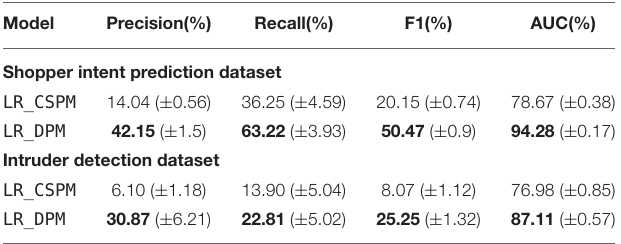
TABLE 3 | Comparison of averaged intent classification performance by using Logistic Regression model on CSPM and DPM features over 10 random Train-Test